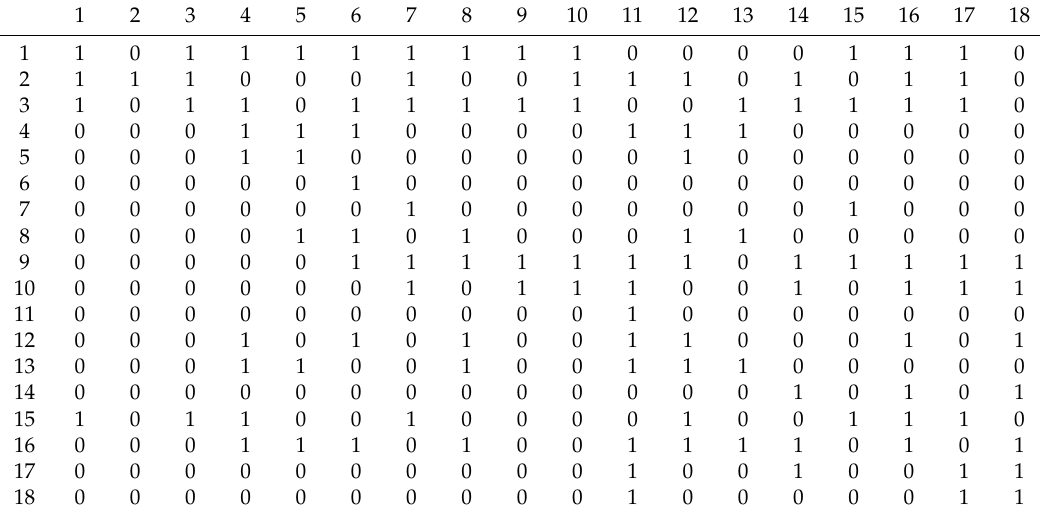
Table 4. Initial reachability matrix for enablers of knowledge management implementation in the healthcare sector of